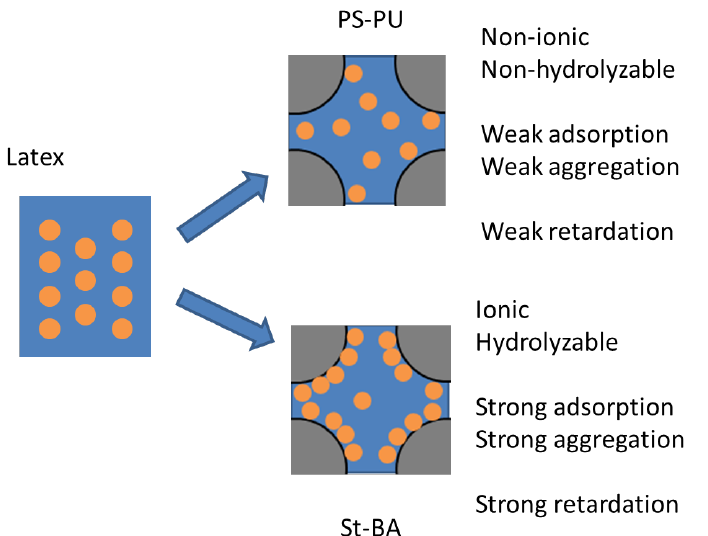
Figure 7. Mechanism for PS-PU and St- BA’s different impact s on cement workability and strength.